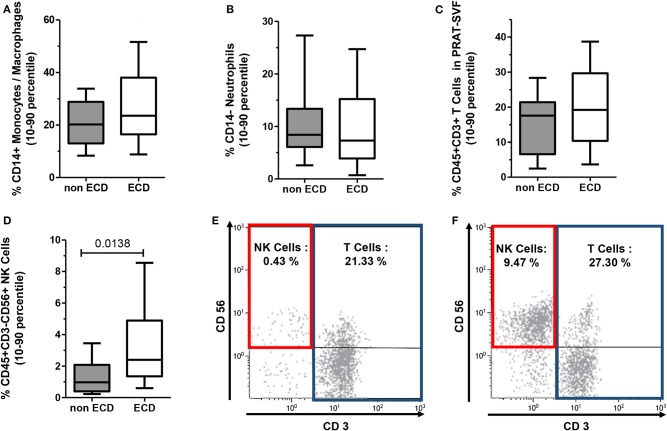
The distribution of CD45+ hematopoietic cells composing the PRAT-SVF of ECD and non-ECD donors was analyzed using flow cytometry according to the gating strategy illustrated in Supplementary Figure 1. Results on the graphs are reported as box and whiskers plots representative of median values, and 25–75 interquartile ranges (Boxes) and error bars indicative of 10–90 percentile ranges. (A) CD14+ Monocyte/Macrophage subset. (B) CD14-neutrophil subset. (C) CD3+ T lymphocytes. (D) CD3−CD56+ NK cells. (E) Histograms illustrate the gating and % of CD3+ T cells and CD3-CD56+ NK Cells observed when analyzing PRAT-SVF of a non-ECD donor (0.43% of NK Cells) or (F) PRAT-SVF from an ECD donor (9.47% of NK cells).